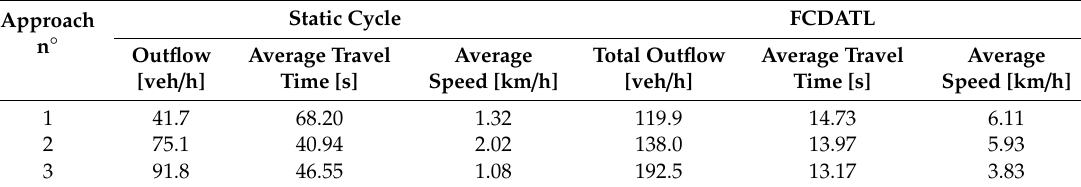
Table 4. Experimental results for